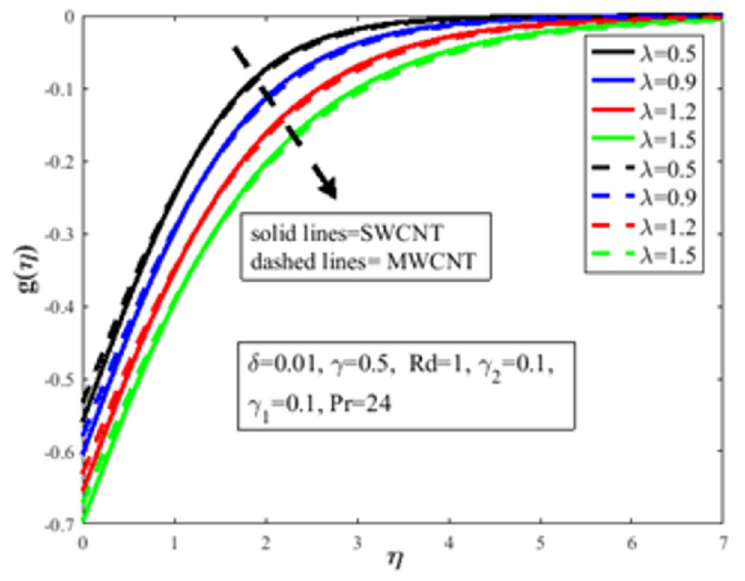
Fig 8. Effect of λ on g ( η